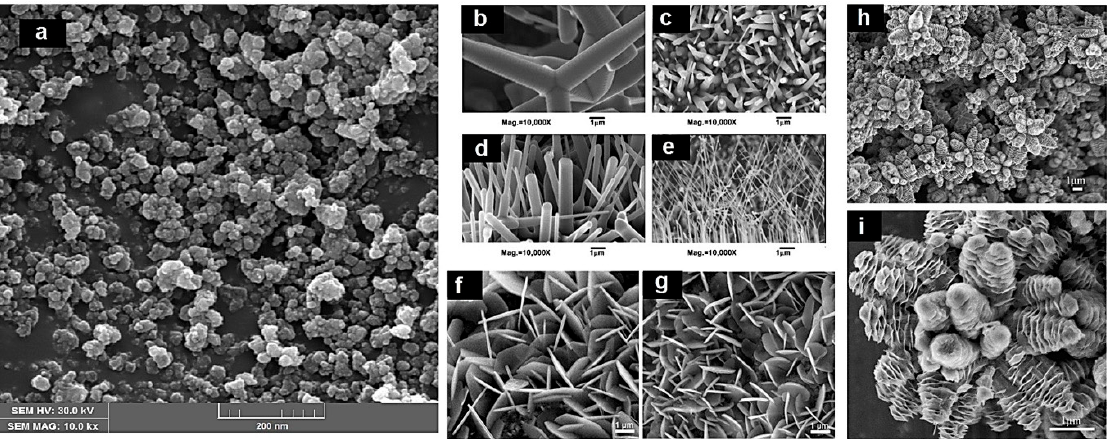
Figure 4. Scanning electron microscopy (SEM) and field emission SEM (FESEM) images for: ( a ) 0D (nanoparticles); ( b – e ) 1D (nanorods); ( f , g ) 2D (nanofilms); and ( h , i ) 3D (nanoflowers), respectively. Reprinted with permission from References [50–53]. Copyright 2009, 2013, and 2014, respectively, with permission from Elsevier.